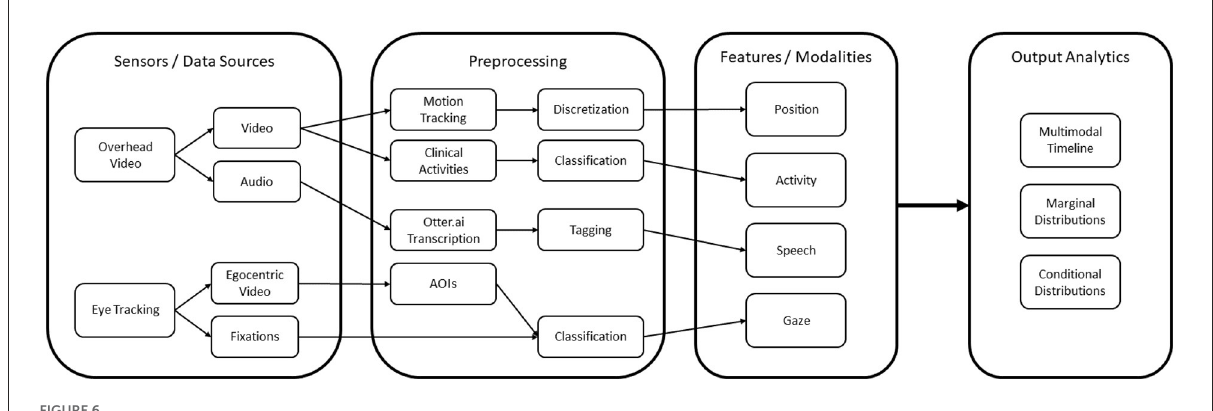
FIGURE6 The overall computational architecture used for the quantitative analysis.